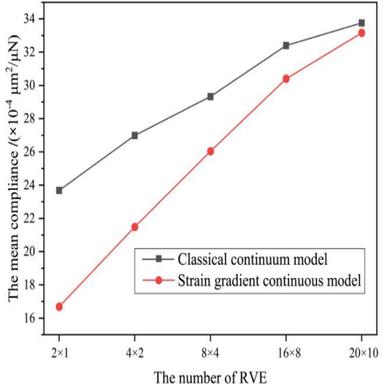
Change trend of objective function of two methods.